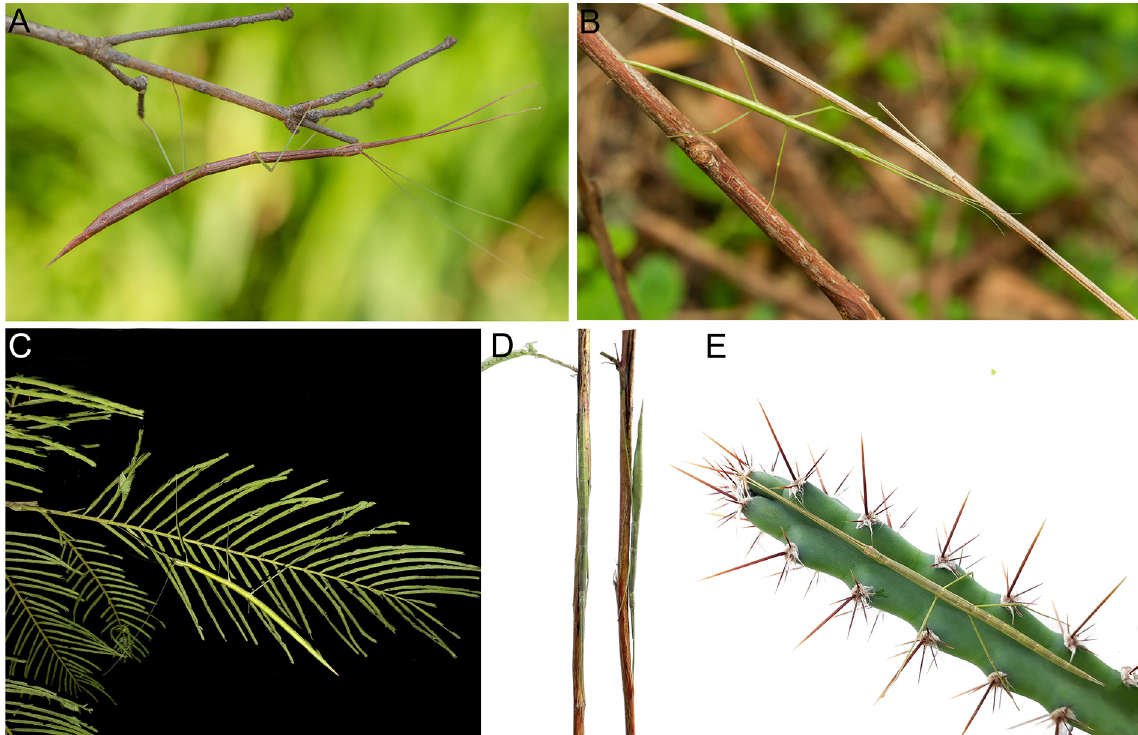
Fig. 2. Live habitus of Arumatia dubia (Caudell, 1904) gen. et comb. nov. A–B . ♀♀ from Barretos, São Paulo, Brazil. C . Adult ♀ (MZUSP V0547) from Araguari, Minas Gerais, Brazil. D–E . Adult